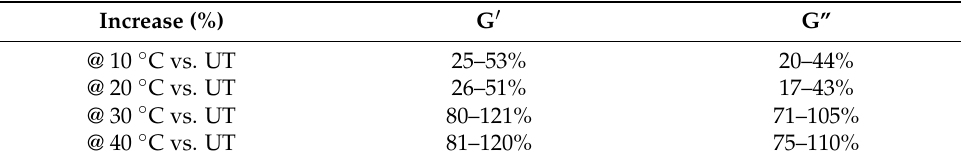
Table 3. Increase in G (cid:48) and G” values for the doughs produced with plasma-treated flour samples (presented as minimum-to-maximum increase in comparison to doughs produced with untreated flour samples) as a function of environmental